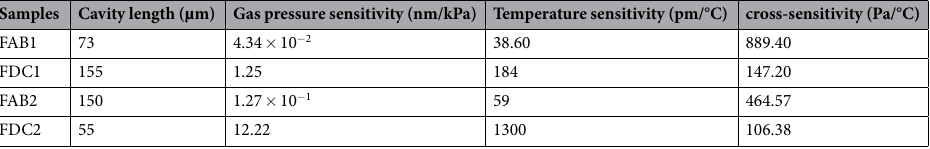
Table 1. Parameter comparison of several FPIs.